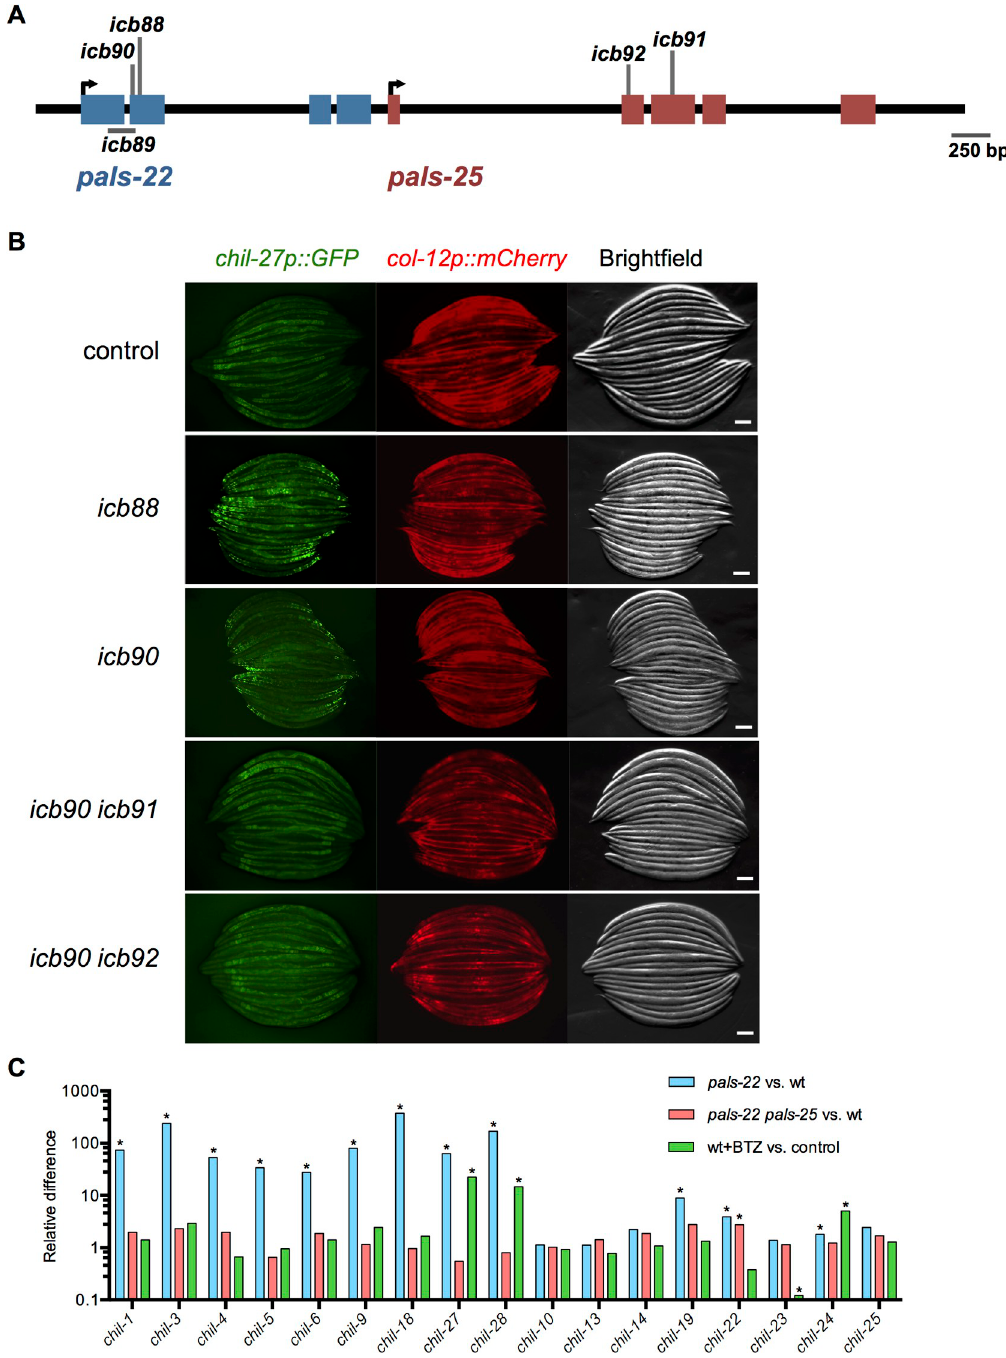
Fig 8. pals-22 and pals-25 regulate expression of chil-27 in the epidermis. (A) pals-22 and pals-25 gene coding structure (UTRs not shown), with blue exons for pals-22 and red exons for pals-25 . See S1 Table for residues altered. (B) Expression of chil-27p :: GFP is regulated by pals-22 and pals-25 . Shown are control, pals-22(icb88) , pals-22(icb90) , pals-22(icb90) pals-25 (icb91) , and pals-22(icb90) pals-25(icb92) animals. The col-12p :: mCherry transgene is constitutively expressed in the epidermis of the early adult. Scale bar, 100 μ m. (C) Relative levels of chil gene expression. pals-22/25 regulate chil genes that are induced upon infection by oomycete. � FDR < 0.01 as calculated by edgeR and limma (see Materials and Methods) indicates the gene is considered to be differentially